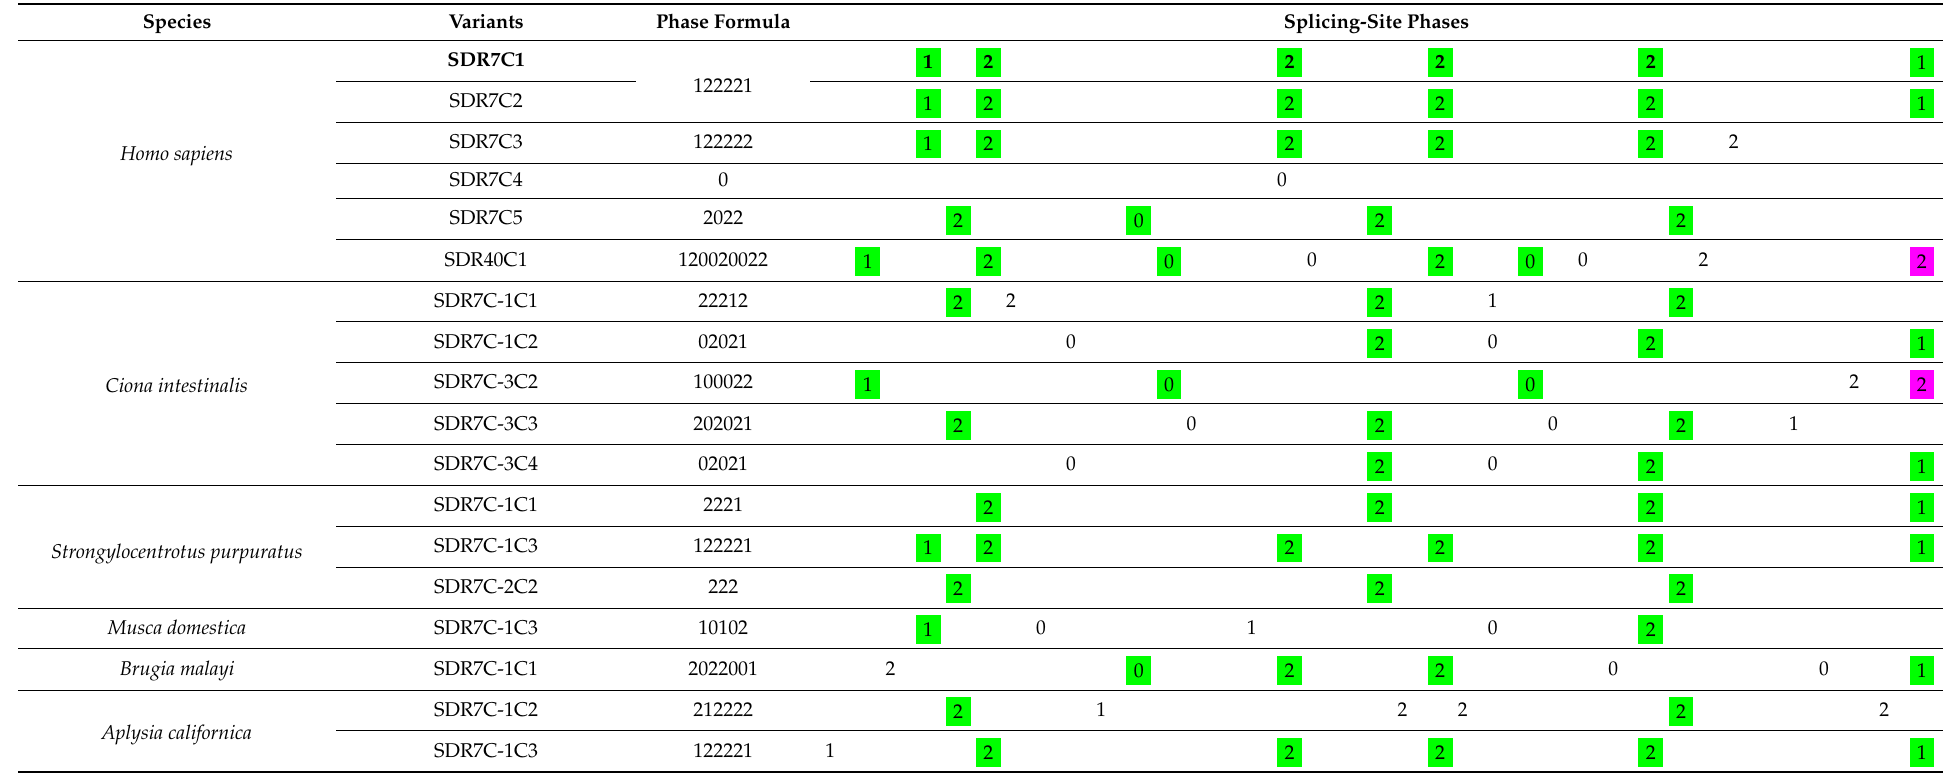
Table 3. Splicing-site organization of the human SDR7C family and SDR40C1 protein variants and their respective invertebrate orthologs. Phase symbols in a same column and highlighted in green or pink, mark the orthologous splicing sites. For other details, see Table